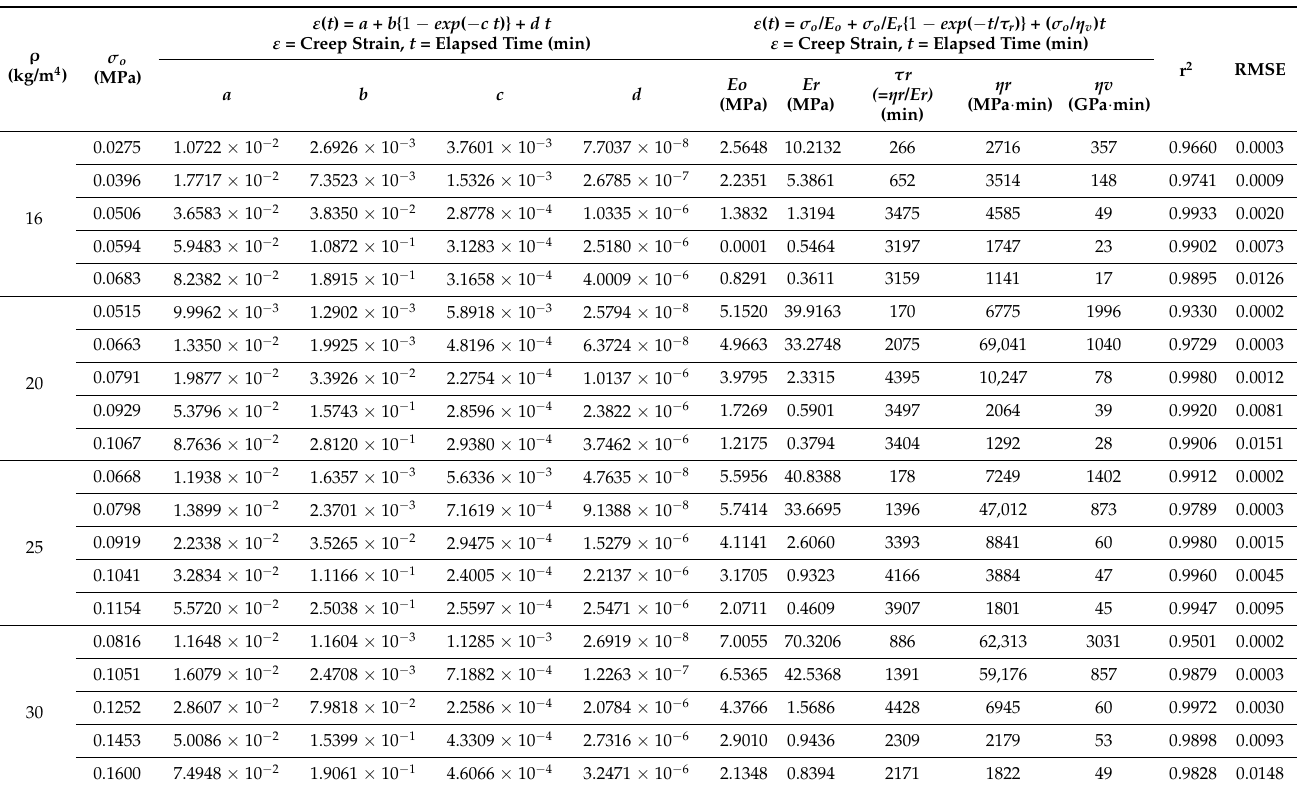
Table 5. Modeling results for the Burgers model, for 12-h-long creep test data and constant-value